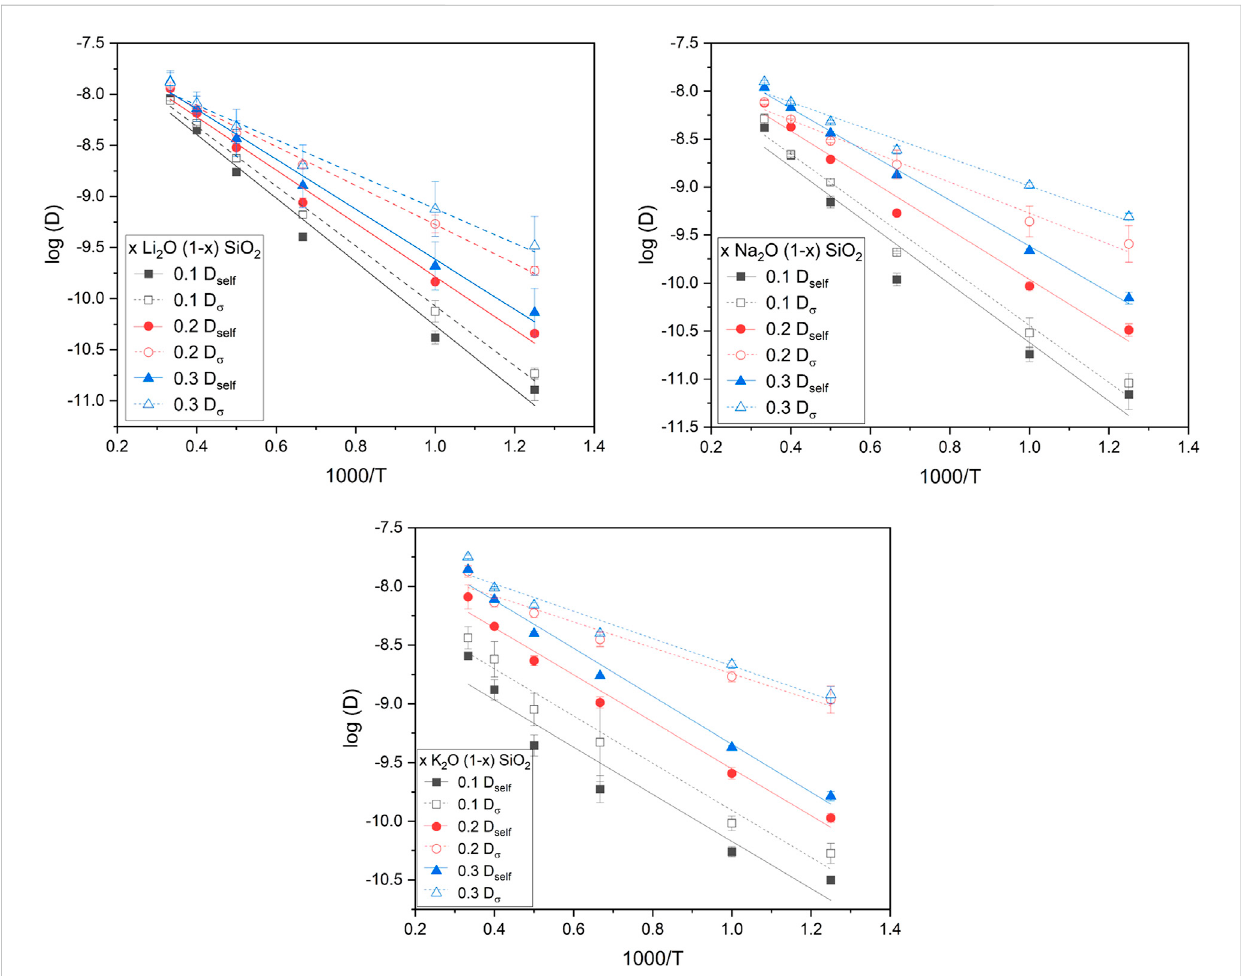
FIGURE 4 Logarithm of the diffusion coef fi cient as a function of the inverse of temperature for the different glasses studied in this work. The linear fi tting ( R 2 ≥ 0.95) indicated an Arrhenius behavior and was used to obtain the activation energies for the different measurements. The error was calculated from the linear regression (OriginPro 2019).